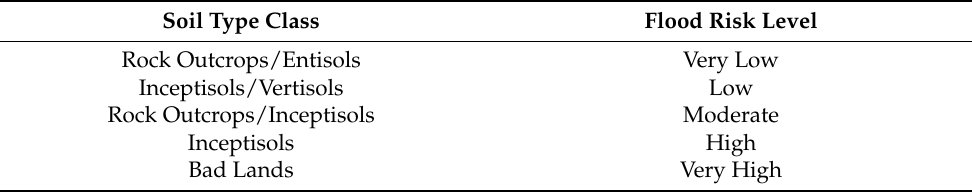
Table 4. The reclassified soil types based on the level of flood